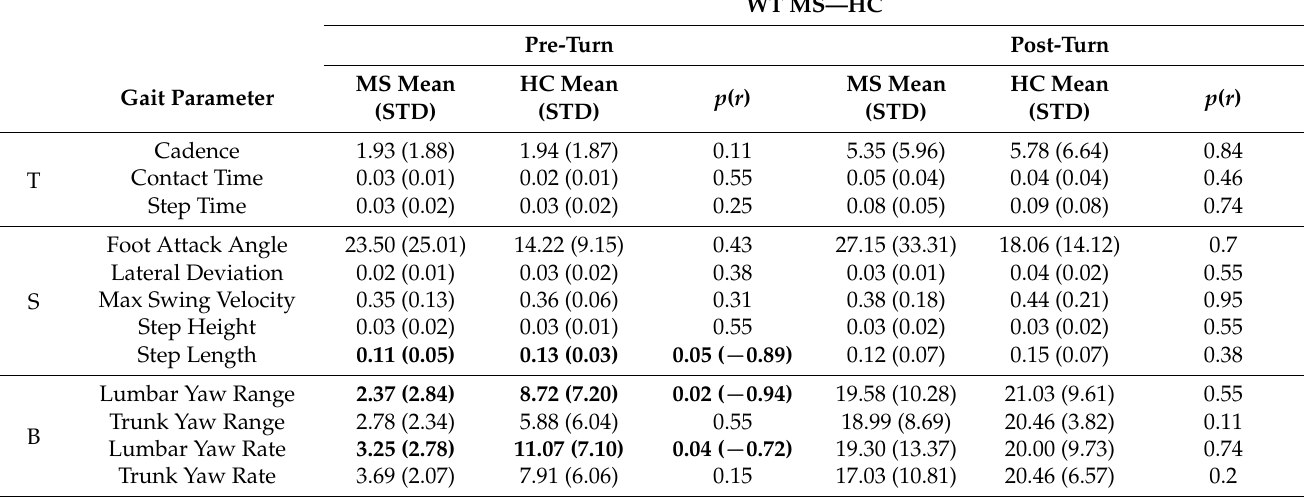
Table 3. Comparisons of gait variability during phases of the walk and turn task between PwMS and controls (HC). p -values ( p ) are reported for each comparison with effect sizes ( r ) indicated for significant